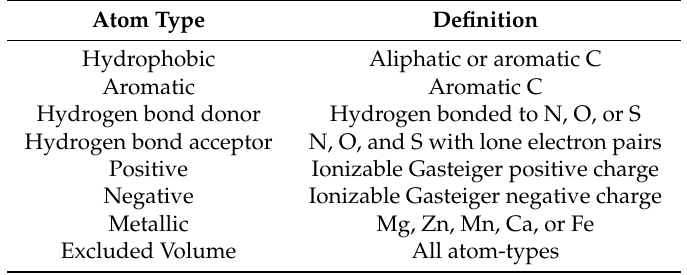
Table 3. Atom types used to classify atoms forming protein-ligand binding